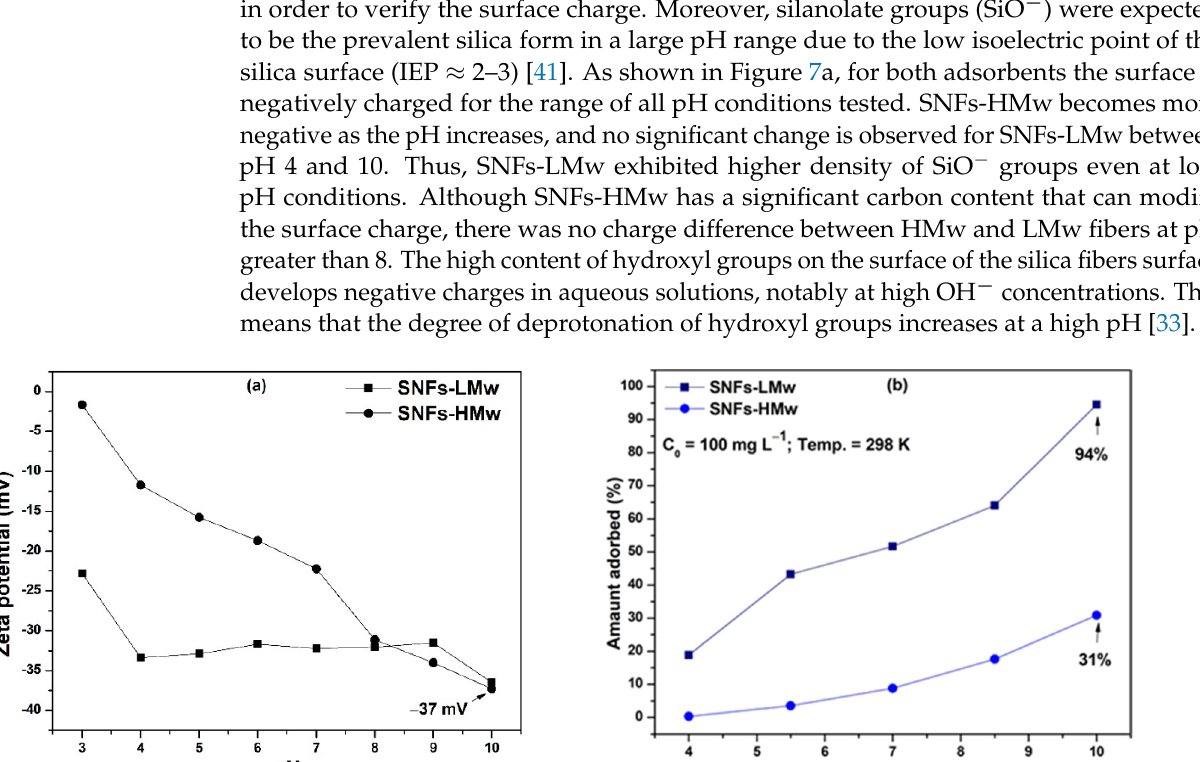
Figure 6. The Langmuir isotherm and linear fit for MB adsorbed by: ( a ) SNFs-LMw and ( b ) SNFs-HMw at 298 K, 308 K, and 318 K.